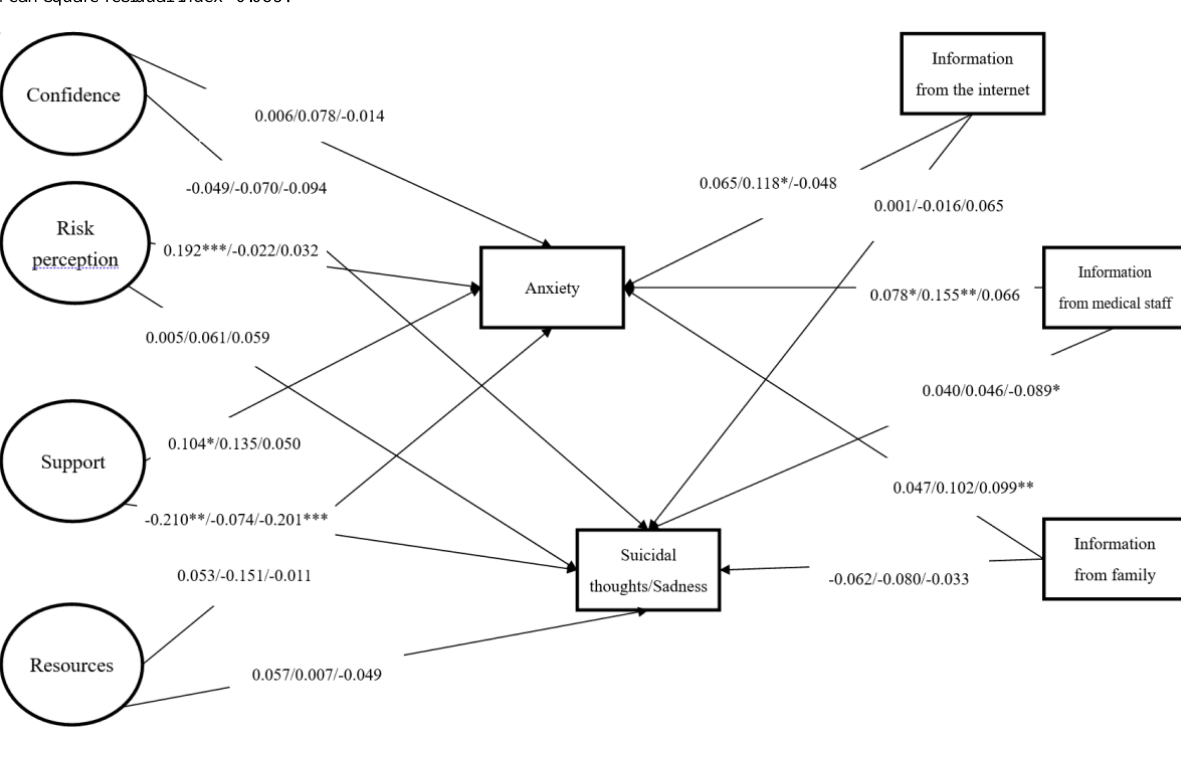
Figure 1. Results of the proposed model showing standardized coefficients among Indonesian, Taiwanese, and Thai students. * P <.05, ** P <.01, *** P <.001. Gender was controlled for in the model. Suicidal thoughts were assessed for Taiwanese and Indonesian students; sadness was assessed for Thai students. Confidence was constructed using (1) confidence to deal with the pandemic, (2) confidence of the city to deal with the pandemic, and (3) confidence of students to deal with the pandemic. Risk perception was constructed using (1) perceived absolute susceptibility to COVID-19 and (2) perceived relative susceptibility to COVID-19. Support was constructed using (1) satisfaction with family support, (2) satisfaction with friend support, and (3) satisfaction with university support. Resource was constructed using (1) sufficiency of personal protective equipment, (2) sufficiency of information, (3) sufficiency of money, (4) sufficiency of medical resources, and (5) sufficiency of psychological support. Fit indices: χ 2378=1035.12; P <.001; comparative fit index=0.92; Tucker-Lewis index=0.90; root mean square error of approximation=0.051 (90% CI 0.048-0.055); standardized root mean square residual